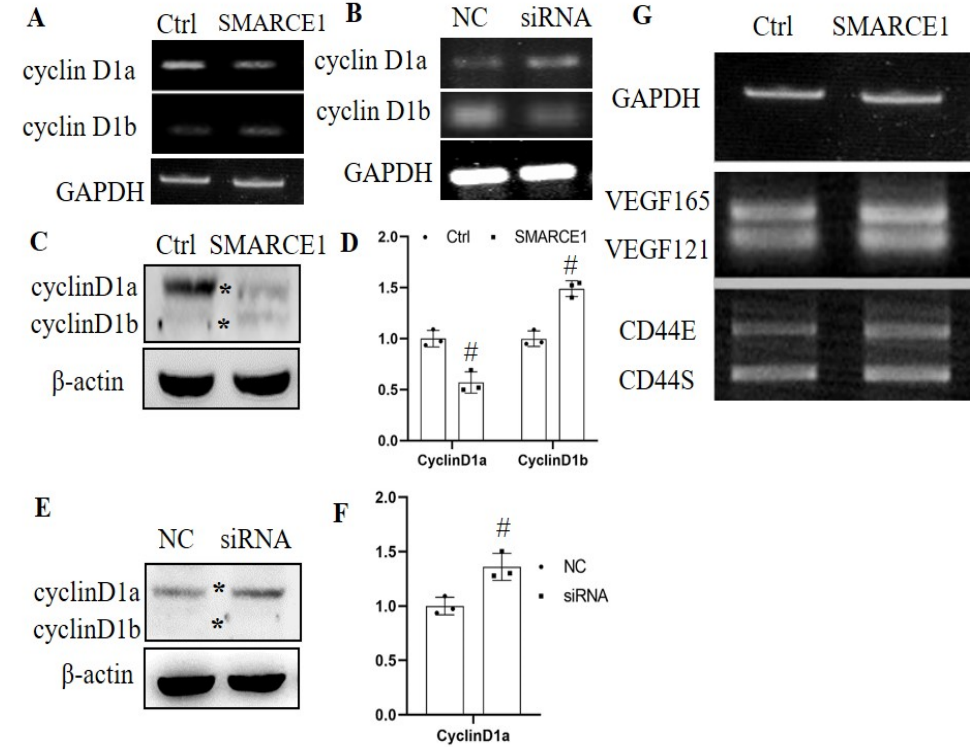
Figure 3. SMARCE1 influenced the alternative splicing of cyclin D1. The alternative splicing of cyclin D1 was detected by reverse transcription semi-quantitative PCR ( A ) and Western blotting ( C ) at 24 h after pcDNA3.1-SMARCE1 plasmid transfection in HaCaT cells. SMARCE1 siRNA was transfected in HaCaT cells, and the alternative splicing of cyclin D1 was examined at 24 h after transfection by reverse transcription semi-quantitative PCR ( B ) and Western blotting ( E ). Non-sense control (NC) siRNA were used as control. The expressions of cyclin D1a and cyclin D1b in C and E were quantified by Image J software and are shown in ( D ) and ( F ), respectively. ( G ). The alternative splicing of VEGF and CD44 was also tested at 24 h after pcDNA3.1–SMARCE1 plasmid transfection. pcDNA3.1–GFP plasmid served as control (Ctrl) group. Data present three sets of independent experiments. # p < 0.05 vs. the Ctrl or NC group. The stars * indicate the bands of gene